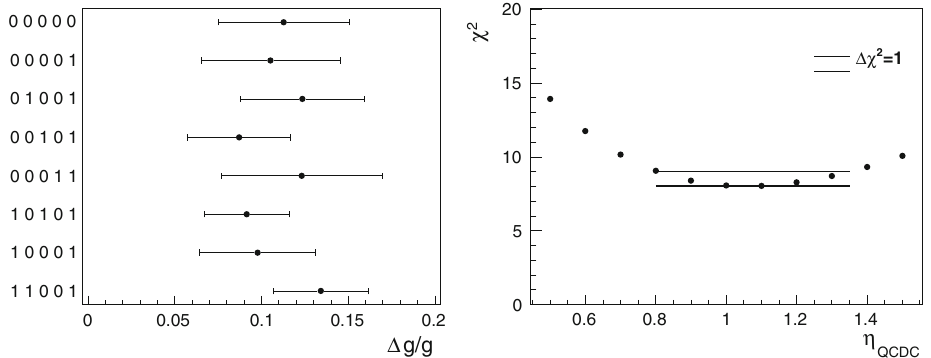
Fig. 4 Left panel Extracted values of (cid:3) g / g and their statistical uncer- tainties for eight different MC simulations. A digit ‘1’ at a certain posi- tion in the 5-digit code shown on the ordinate means that the corre- sponding simulation parameter was used differently as compared to the code00000simulationthatwasusedfortheextractionofthefinal (cid:3) g / g results. The meaning of the digits is as follows (from left to right ): 1st